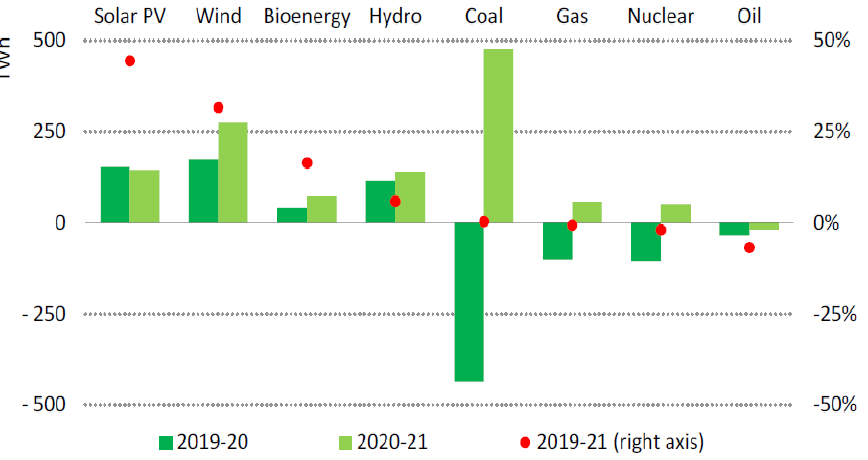
Figure 6. Changes in electricity generation between 2020 and 2021 [53]. Source: IEA (2021) Global Energy Review 2021. All rights reserved.